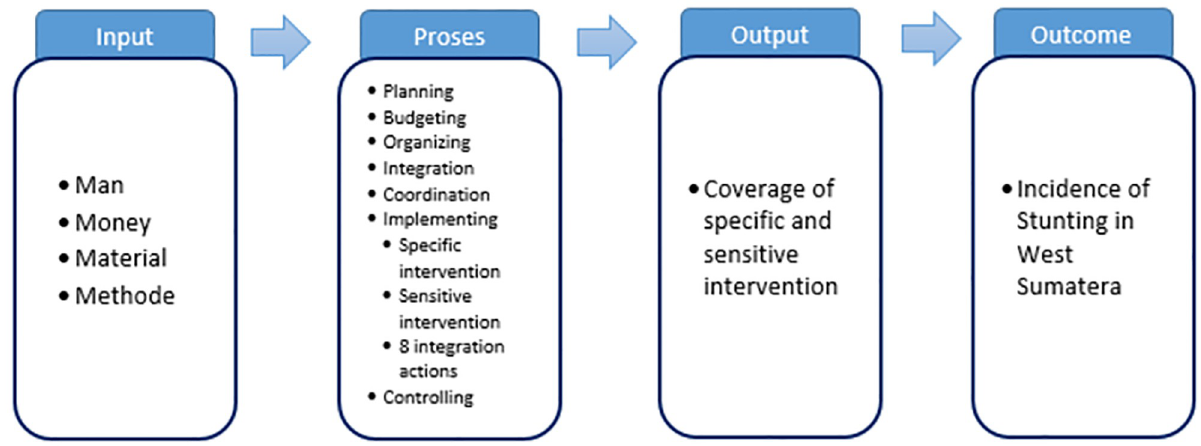
Fig 1. Theoretical framework for analysing driving and inhibiting factors in stunting reduction acceleration program in West Sumatra in 2021.